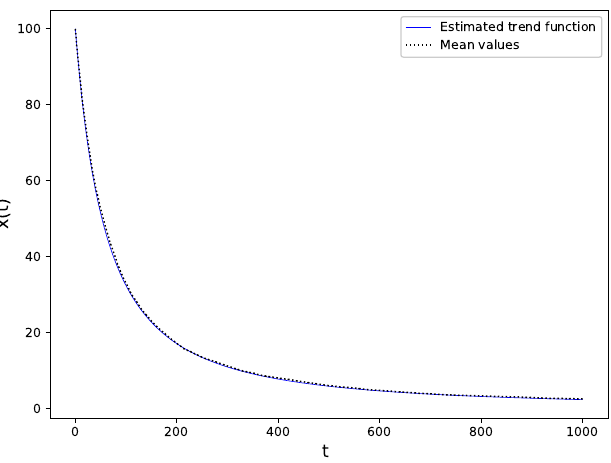
Figure 2. ETFs vs. the mean values of simulated